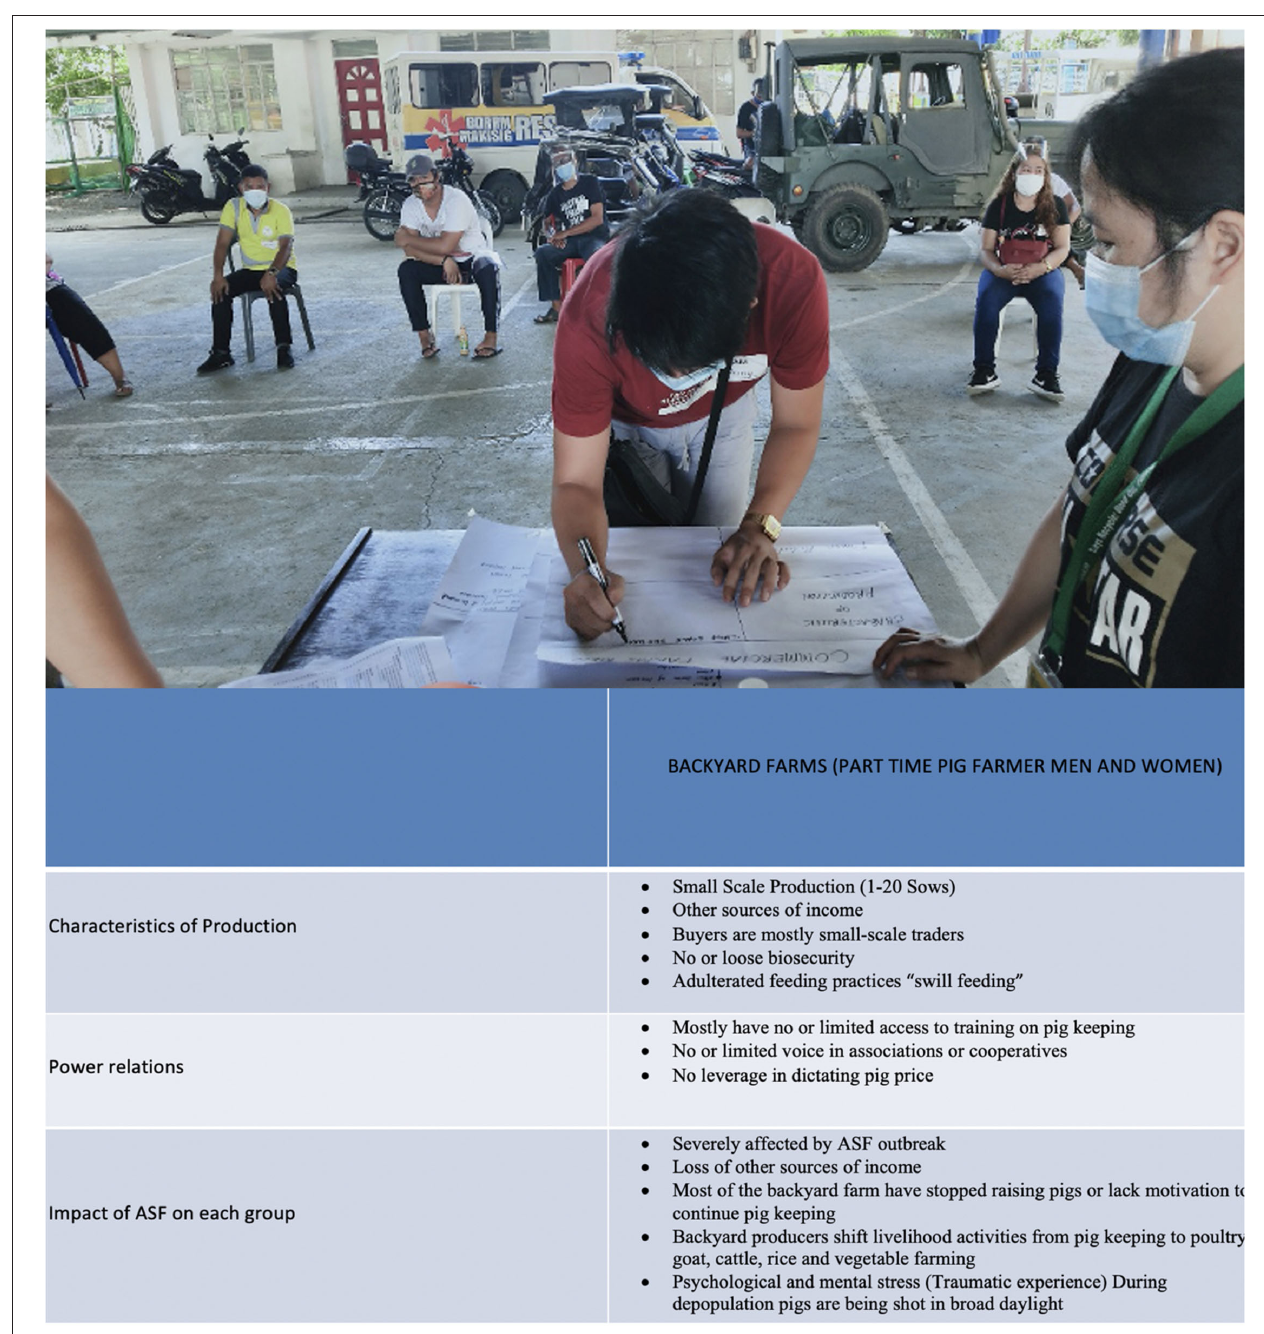
FIGURE 6 | Farmers create a social inclusion matrix during a network mapping exercise in Nueva Ecija (photo top and digitised extract bottom).